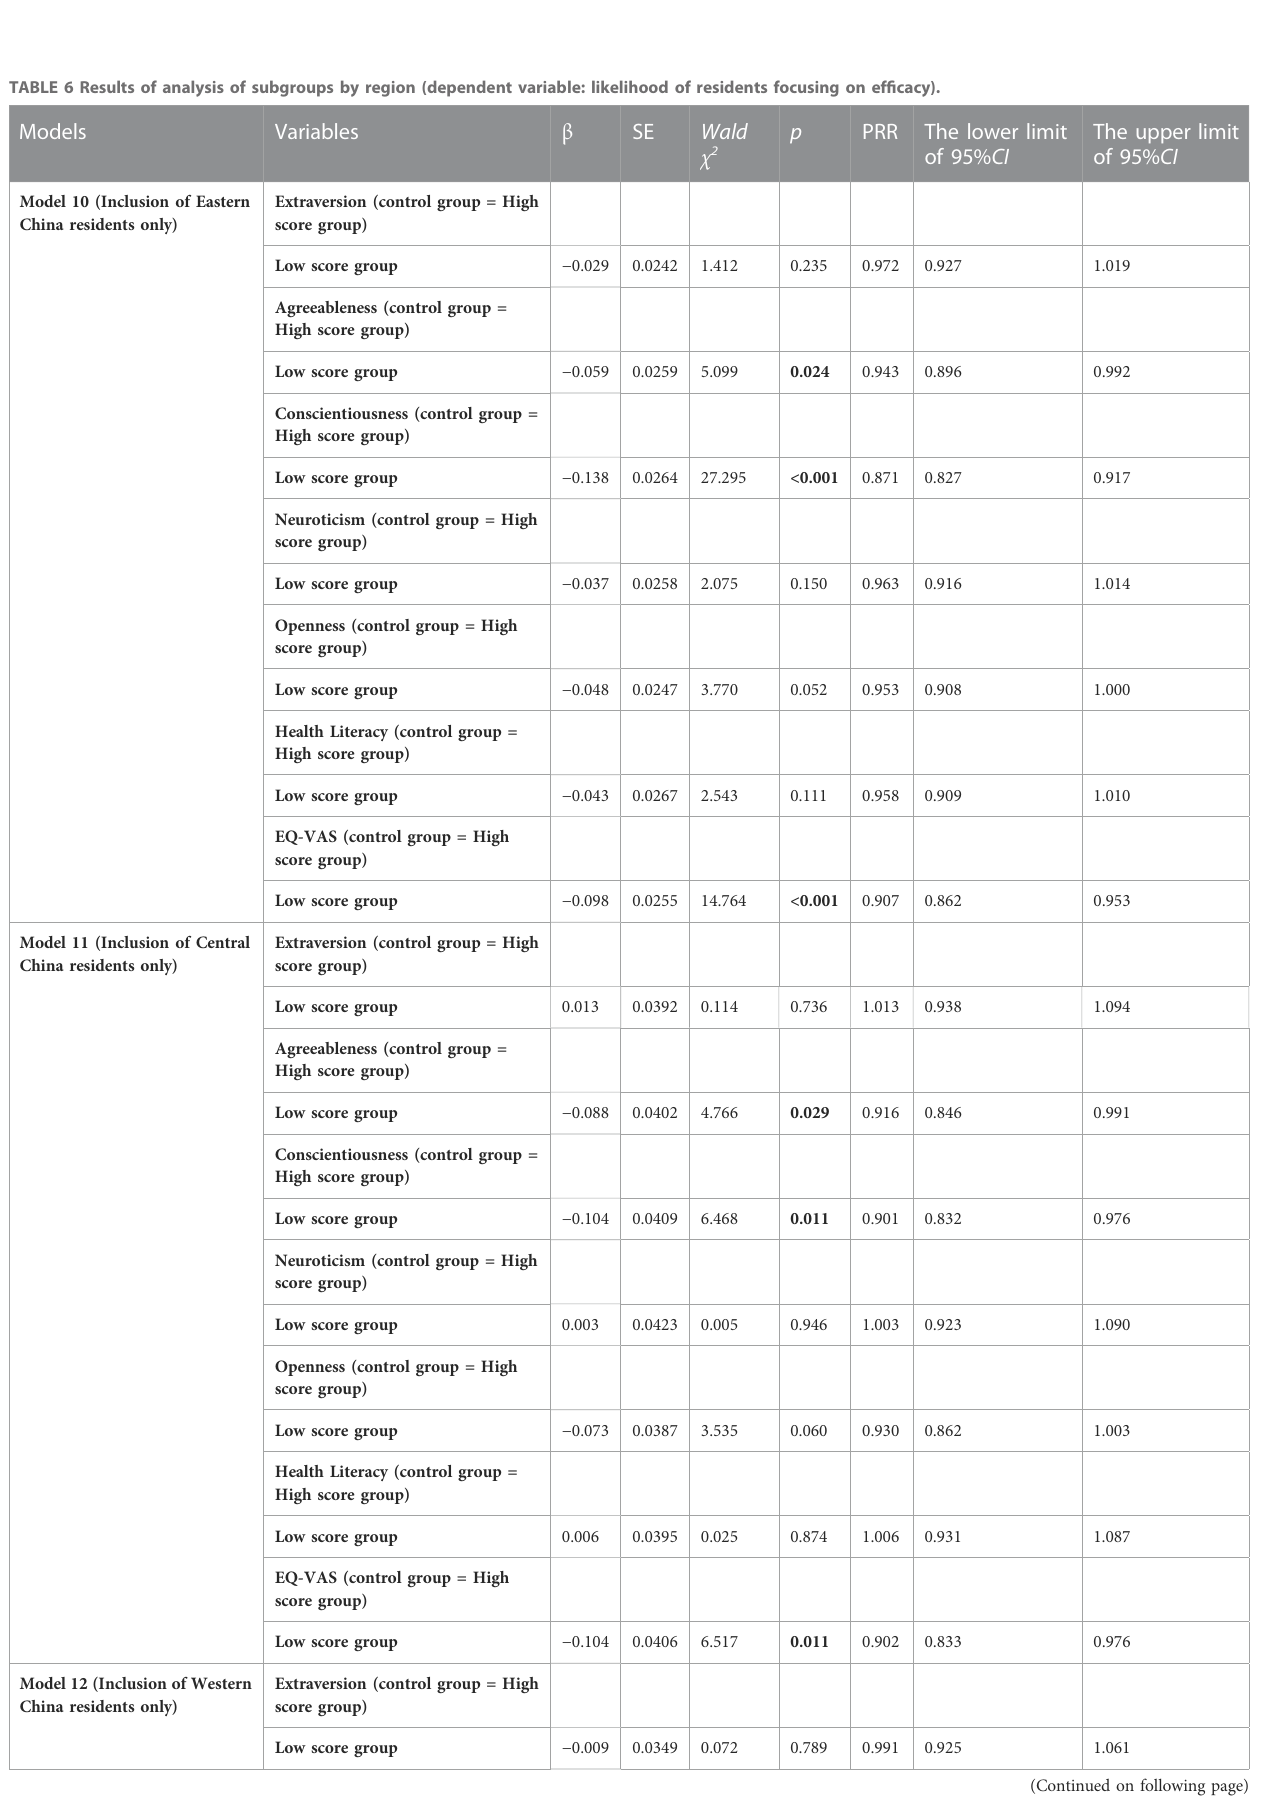
TABLE 6 Results of analysis of subgroups by region (dependent variable: likelihood of residents focusing on ef fi cacy). Models